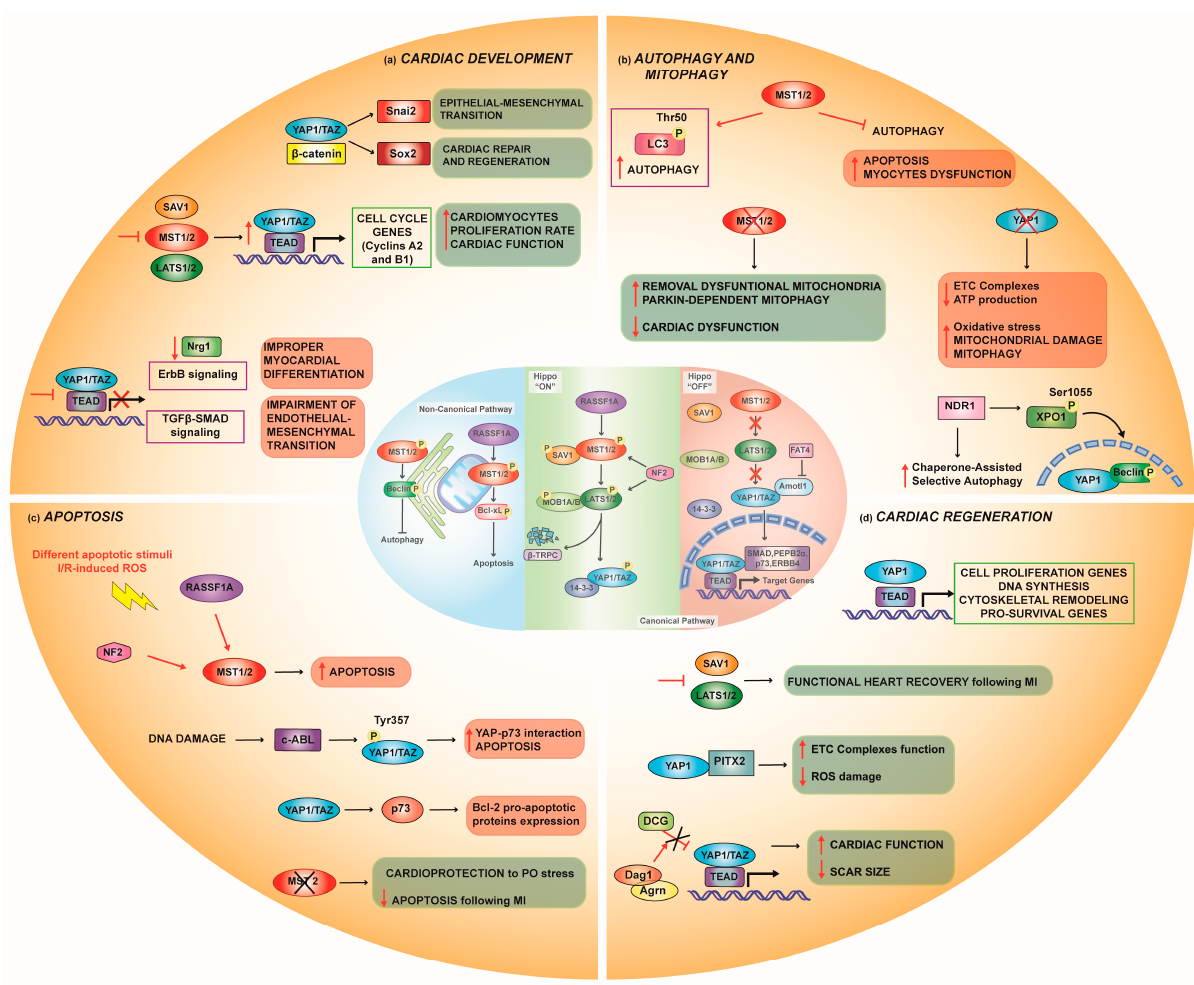
Figure 2. The Hippo pathway in cardiovascular physiology. ( a ) YAP1 expression is involved in car- diac development: the Wnt/ β -catenin pathway synergically works with YAP1 to induce cardio gen- esis; nuclear YAP1 mediates cell cycle genes (cyclins A2 and B1), prompting cardiomyocyte prolif- eration; and YAP1 loss inhibits either ErbB or TGF- β -SMAD signaling with consequent improper myocardial development. ( b ) Hippo signaling controls autophagy and mitophagy: MST1/2